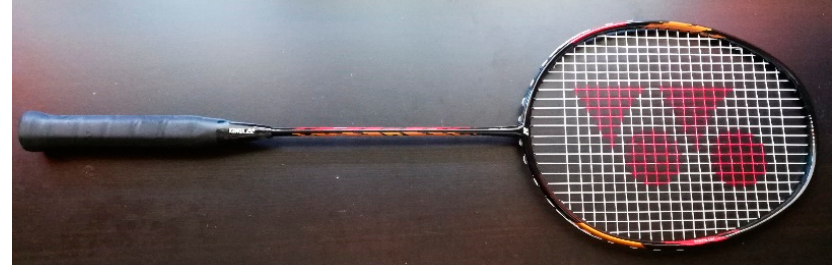
Figure 2. Yonex Duora 33. Length: 675 ± 3 m; width: 189 ± 3 mm.